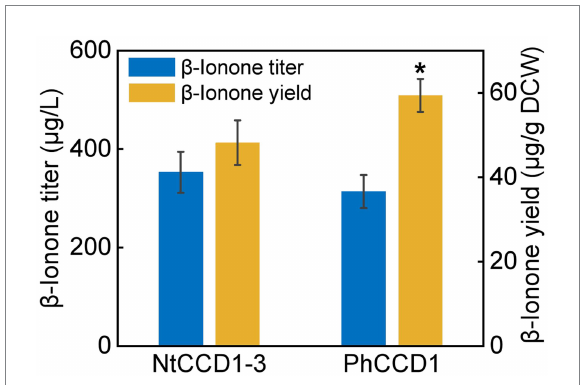
FIGURE 2 Comparison of β -ionone titer and yield of strains A10-rox1- NtCCD1-3 (NtCCD1-3) and A10-rox1-PhCCD1 (PhCCD1). Error bars represent the standard deviation of three biological replicates. p values were determined by one-way ANOVA (* p < 0.05).